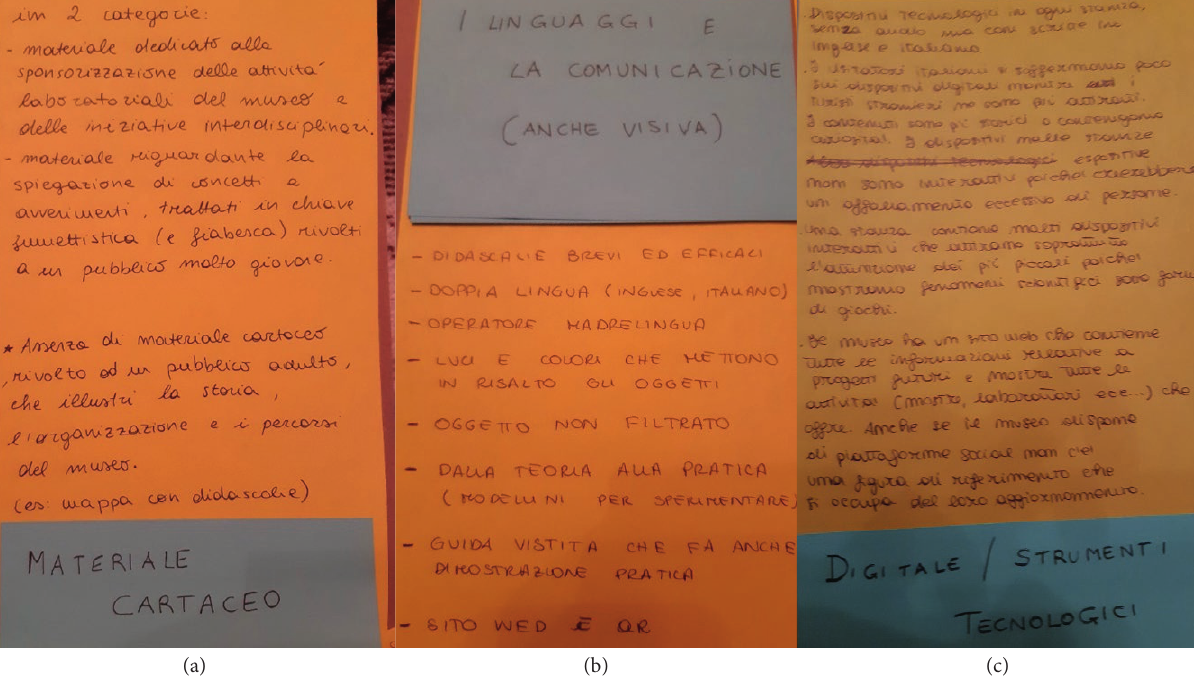
Figure 3. Observations and comments made by the students during the visit at the Science Museum concerning several aspects as indicated in Table 1: comments about (a) the presence of catalogue, captions and brochures; (b) the language used, the type of communication, the presence of a web-site, eventual videos and animations; (c) the presence of interactive and digital tools, educational